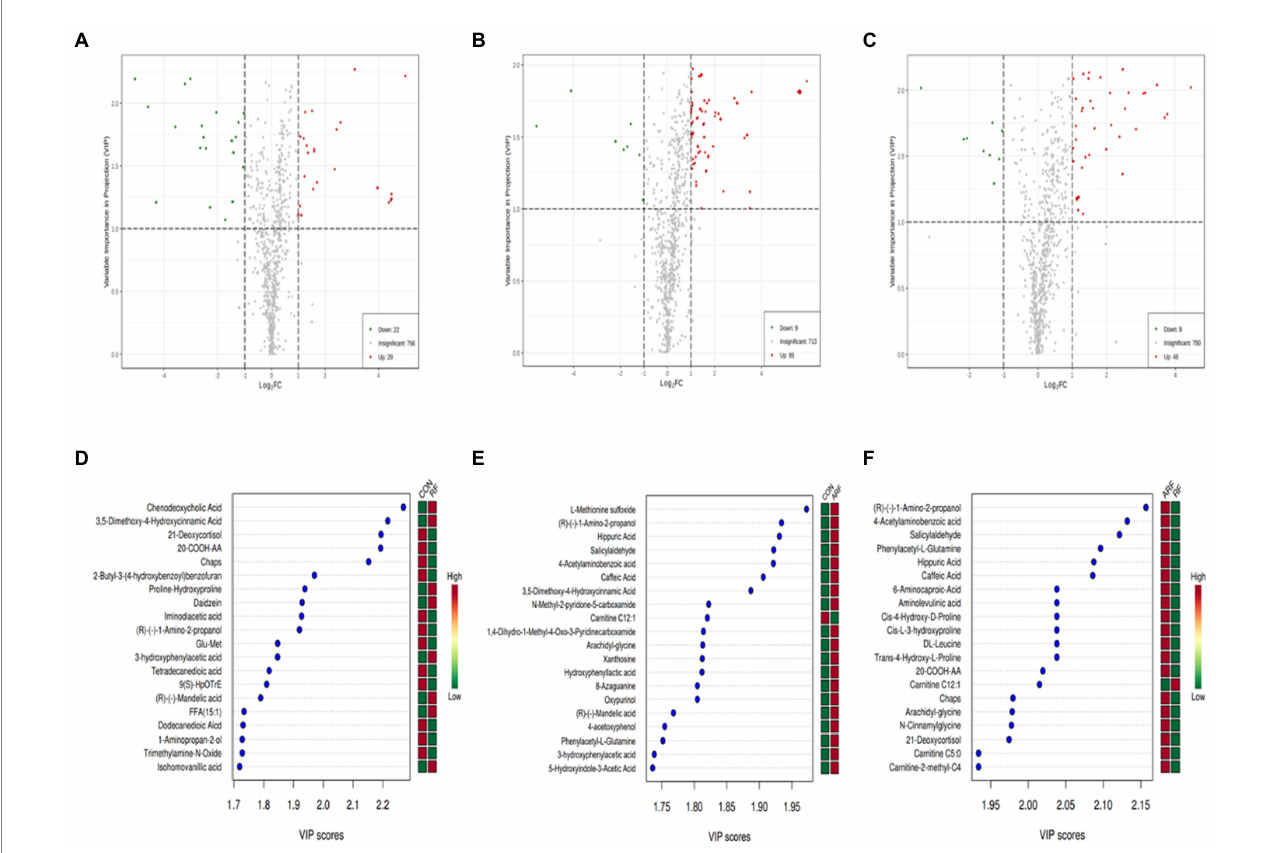
FIGURE 6 Differential metabolites in lamb serum inoculated with ruminal fluid. Volcano plots of the affected metabolites in CON VS RF (A) , CON VS ARF (B) and RF VS ARF (C) . Each point represents a metabolite. The green dots in the figure represent the down-regulated differential metabolites, the red dots represent the up-regulated differential metabolites, and the gray dots represent the metabolites without difference. Metabolites are ranked by variable importance in projection analysis (VIP) of respective groups: CON group and RF group (D) , CON group and ARF group (E) and RF group and ARF group (F) ; the top 20 important metabolites were arranged from top to bottom according to intracellular concentration. The red box represents an up-regulated concentration of the molecule and the green box represents down-regulated